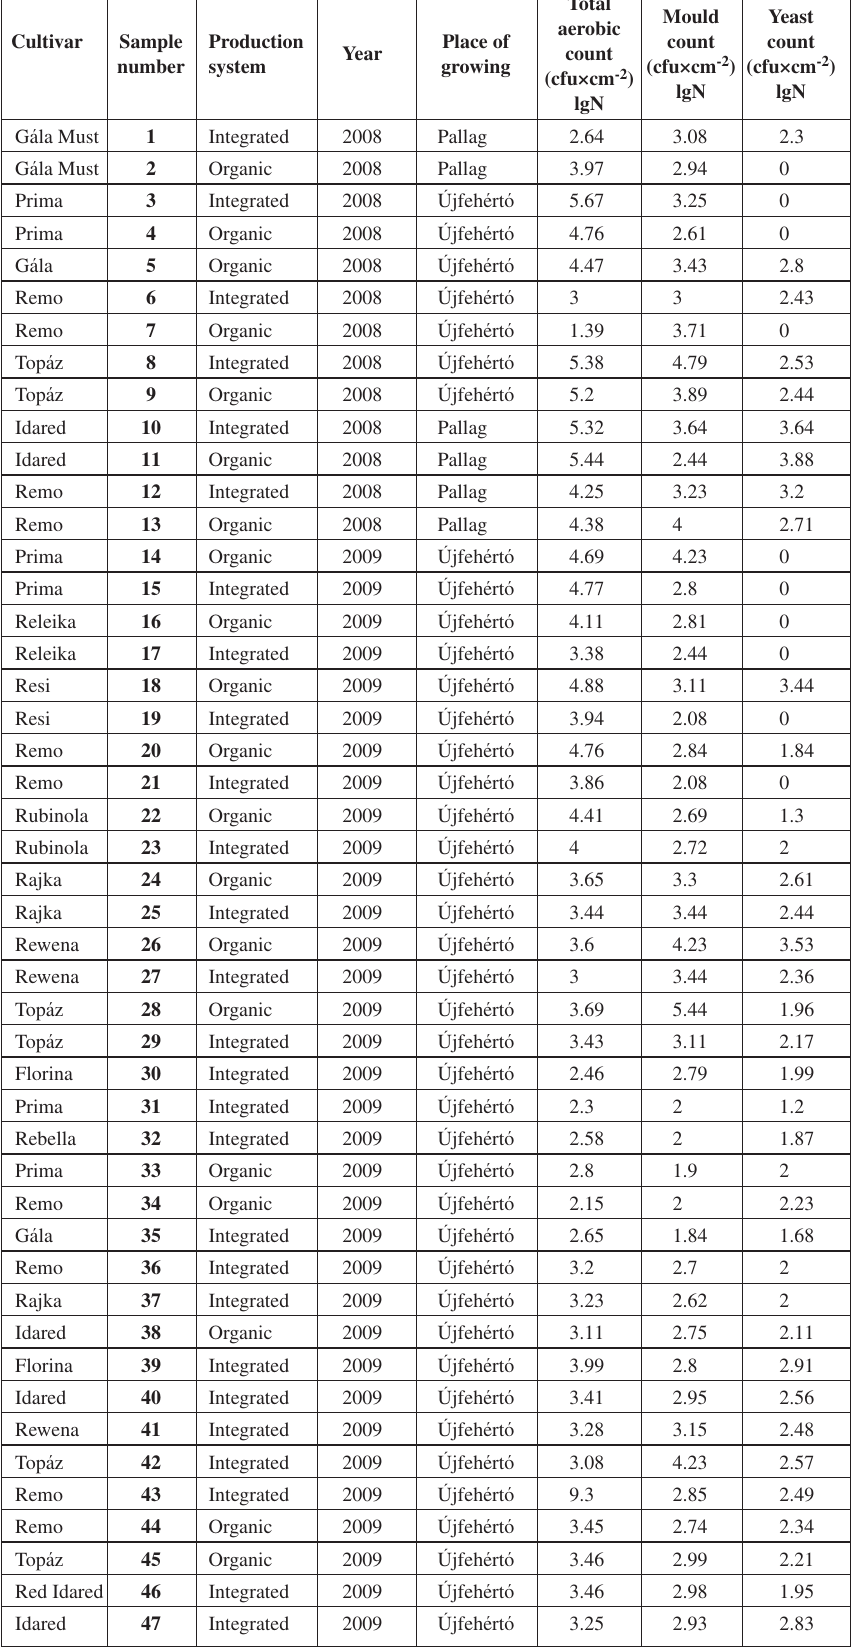
Table 1. Microbial contamination of apple